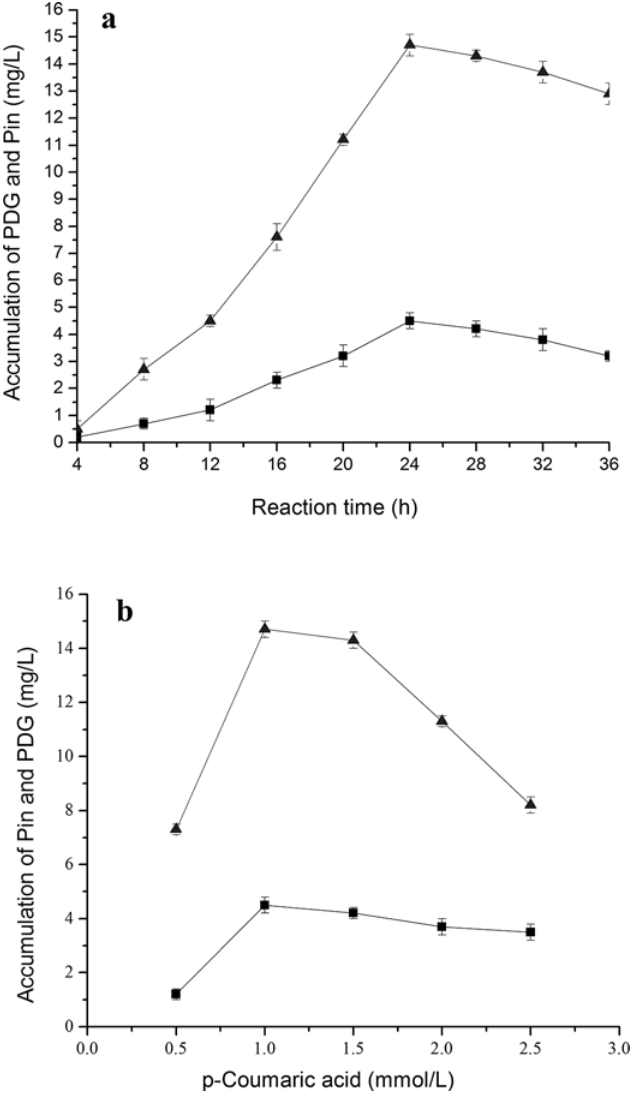
Fig 4. Effects of p- coumaric acid additions on PDG and Pin production. The signals in the figures indicate PDG (square), Pin (triangle). The used condition is 1.0 mmol/L p -coumaric acid additions (a) and reaction time of 24 h (b).